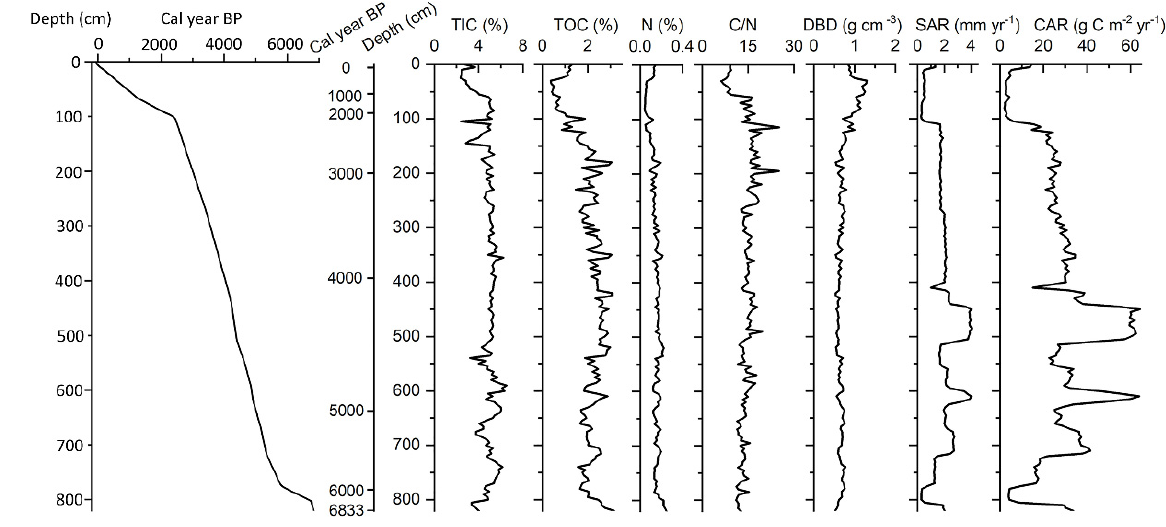
Figure 3. Temporal variation patterns of the sediment’s total inorganic carbon content (TIC), total organic carbon (TOC), total nitrogen (TN), the ratio of TOC and TN (C/N), the calculated dry bulk density (DBD), sediment accumulation rate (SAR), and carbon accumulation rate (CAR) in Huangqihai Lake. The TOC and TN values were obtained from [20].